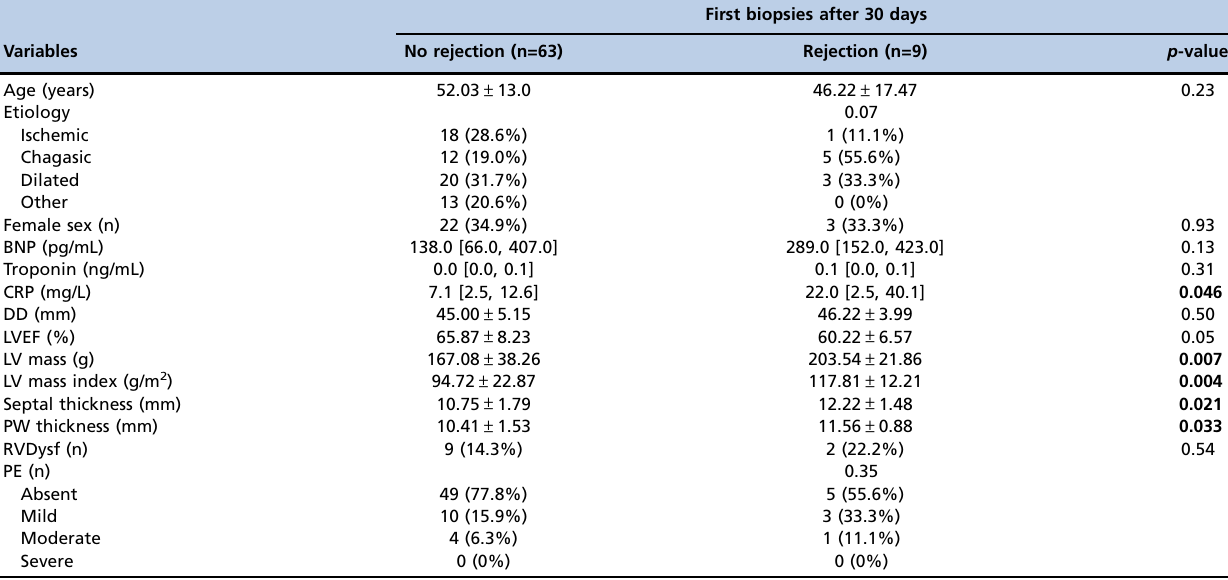
Table 1 - Serum biomarkers and echocardiography parameters for ACR